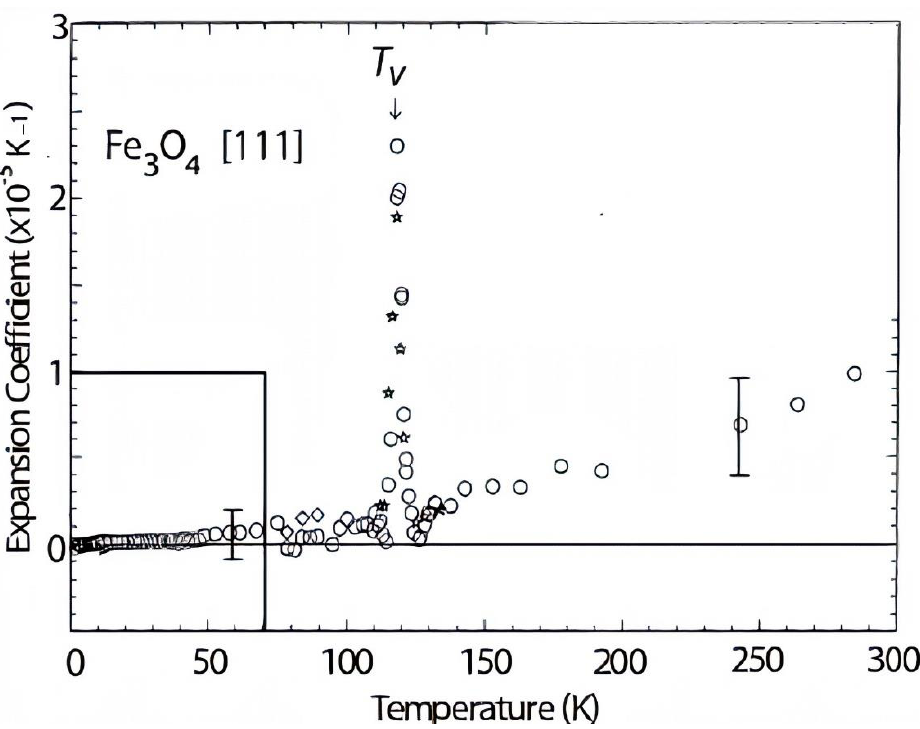
Figure 17. Thermal expansion coefficients of Fe 3 O 4 at different temperatures, stars refer to the cooling run and circles refer to the heating run (T = 4.2 – 300 K).